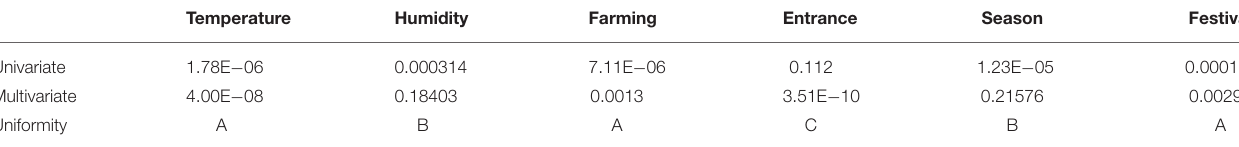
TABLE 3 | Analysis results of significance.